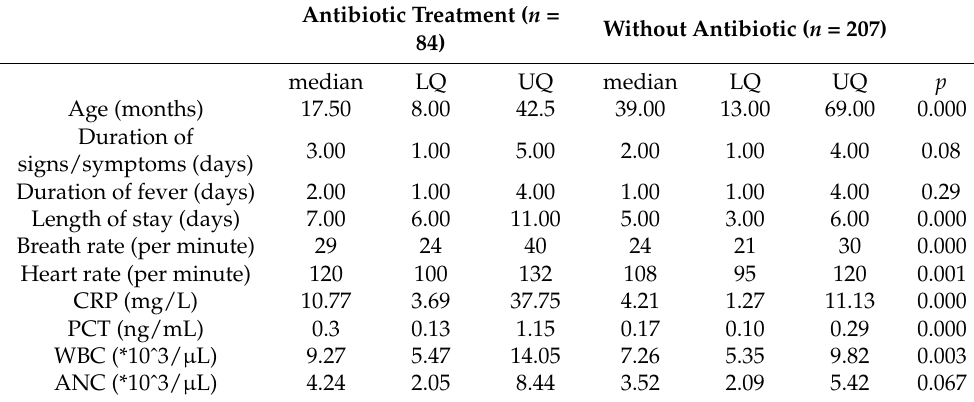
Table 2. Baseline characteristic in the group without previous antibacterial therapy (No-PAT) ac- cording to the need of antibiotic therapy during hospitalization. Abbreviations: LQ—lower quartile, UQ—upper quartile, CRP—C-reactive protein, PCT—procalcitonin, WBC—white blood cells, ANC— absolute neutrophil count.